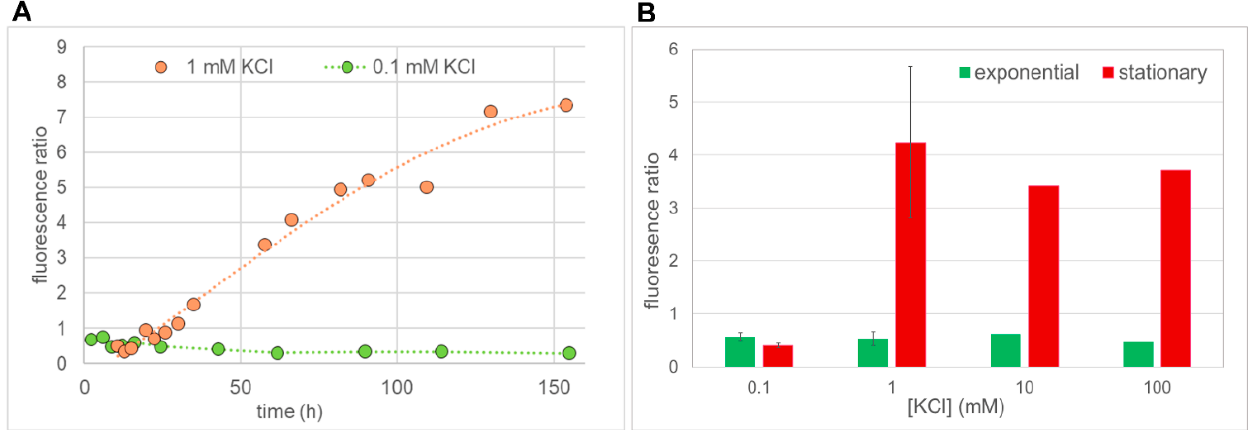
Figure 9. Ratios of BiFC fluorescence of cells expressing TRK1[ Δ LHL]/VN plus TRK1[ Δ LHL]/VC or VN/TRK1[ Δ LHL]/VC. ( A ) Cells were grown in media with either 1 mM or 0.1 mM KCl, as indicated. Dashed lines: 1 mM KCl Phenomenological fit of a polynomial of 4th degree, 0.1 mM KCl: straight lines connecting data points ( B ) Average fluorescence ratios in the exponential (average of measurements between ~5 and ~25 h, green) and stationary growth phases (average of measurements between ~50 and 150 h, red) of cells grown in media supplemented with different [KCl]. The error bars for 0.1 mM KCl and 1 mM KCl represent the standard deviation of these averages from three independent experiments. Data for media with 10 mM and 100 mM KCl are from single-time course recordings.